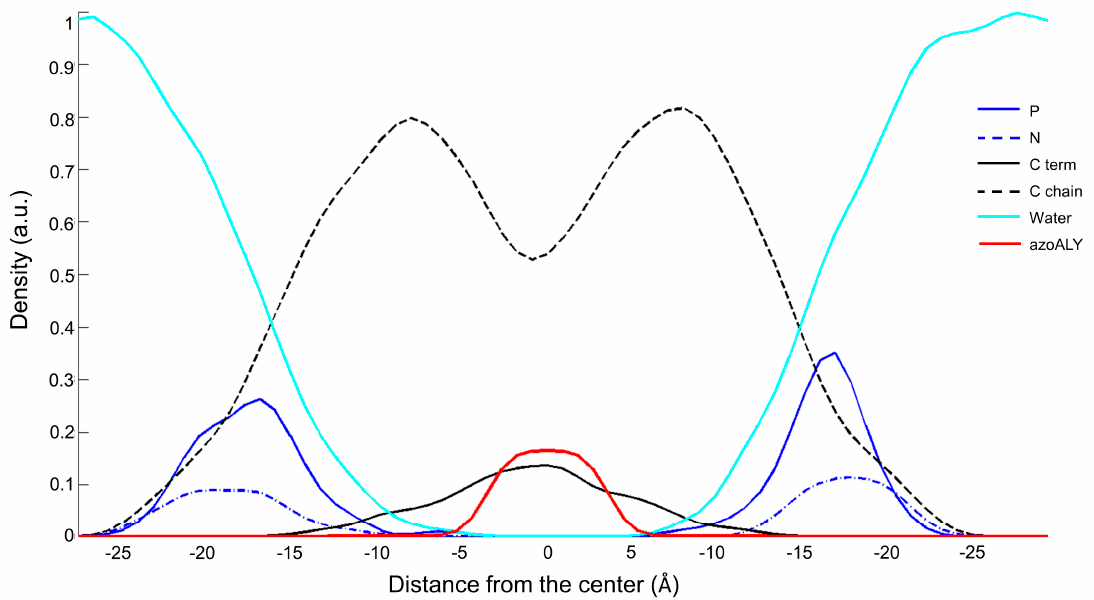
Figure 2. Density profile of the system azoALY-POPC / POPG (9:1) after 45 ns of MD simulation. Cyan line: water molecules; blue line: phosphorous atoms; dashed blue line: nitrogen atoms; dashed black line: carbon chains of the phospholipid, black line: terminal carbons of the phospholipid; red line azoALY peptide.